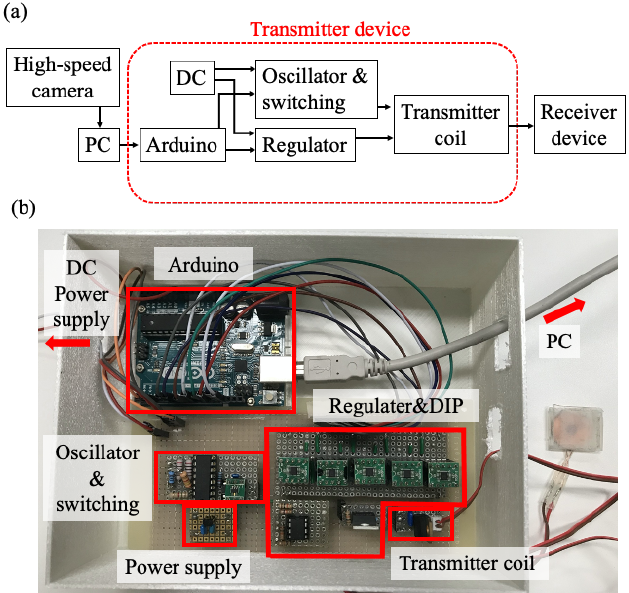
Figure 3. A transmitter device system for a wirelessly powered four-channel neurostimulator. ( a ) A schematic of the transmitter device system; ( b ) the fabricated transmitter